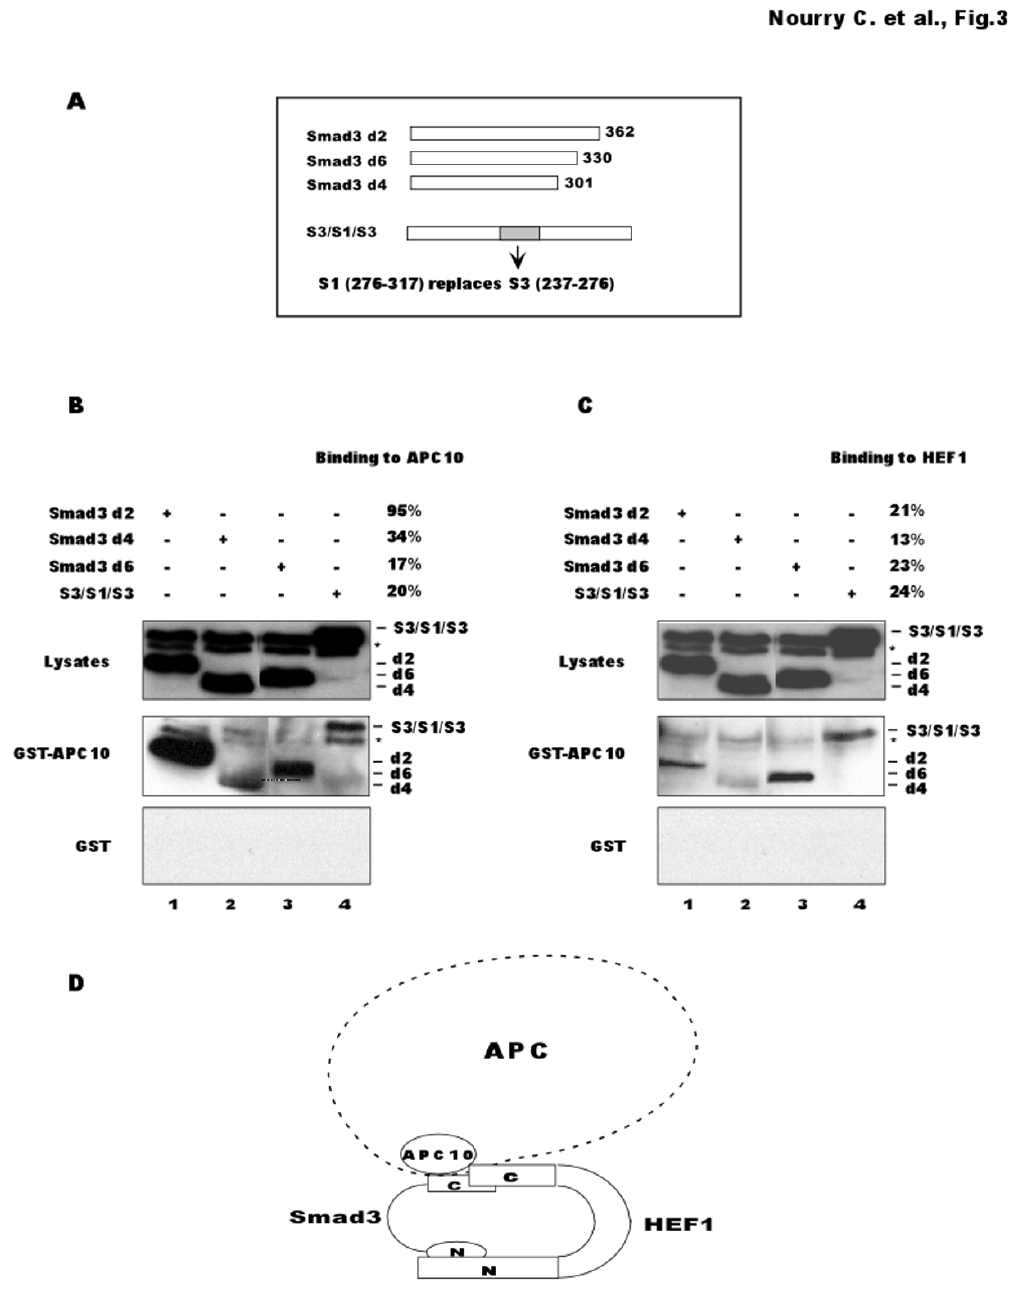
Figure 3 Smad3 MH2 domain contains overlapping but distinct binding sites for HEF1 and APC10. (A) A Cartoon to illus- trate the deletion constructs of Smad3 (Smad3d2, d4 and d6) as well as a hybrid protein S3/S1/S3. (B) GST pull-down assay to map APC10 binding site on Smad3C. Flag-tagged Smad3 deletion mutants were transfected into 293 cells and the cell lysates were tested against GST-APC10. Cell lysates (top panel) and proteins bound to the beads (middle and bottom panels) were analyzed by Western blot with anti-Smad1/2/3 from Santa Cruz. The percentage listed at the right side of the listed constructs is derived from dividing the signals (measured by ImageQuant) of bound proteins in the middle panel by the signals of lysate proteins in the corresponding lane of the top panel and then times 100 percent. (C) GST pull-down assay to map HEF1 binding site on Smad3C. Same as in (B), with GST-APC10 replaced by GST-HEF1. (*) endogenous Smad1 and Smad3 recognized by anti-Smad1/2/3 antibody. (D) A cartoon to illustrate the complex of Smad3, HEF1 and APC10 and their potential interaction with the APC ligase core